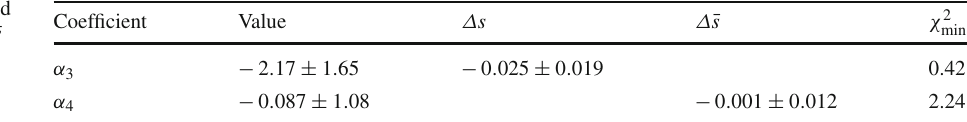
Table 2 Fitting results of α i and calculated results of Δ s and Δ ¯ s